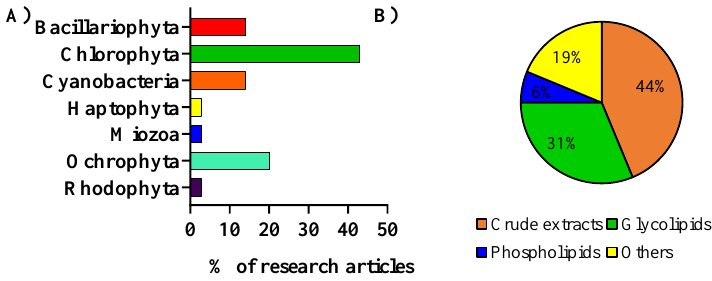
Figure 2. ( A ) Microalgae of different phyla were used in the assays to evaluate the anti-inflammatory activity of lipids. ( B ) Type of lipid extracts from microalgae used to assay the anti-inflammatory activity.